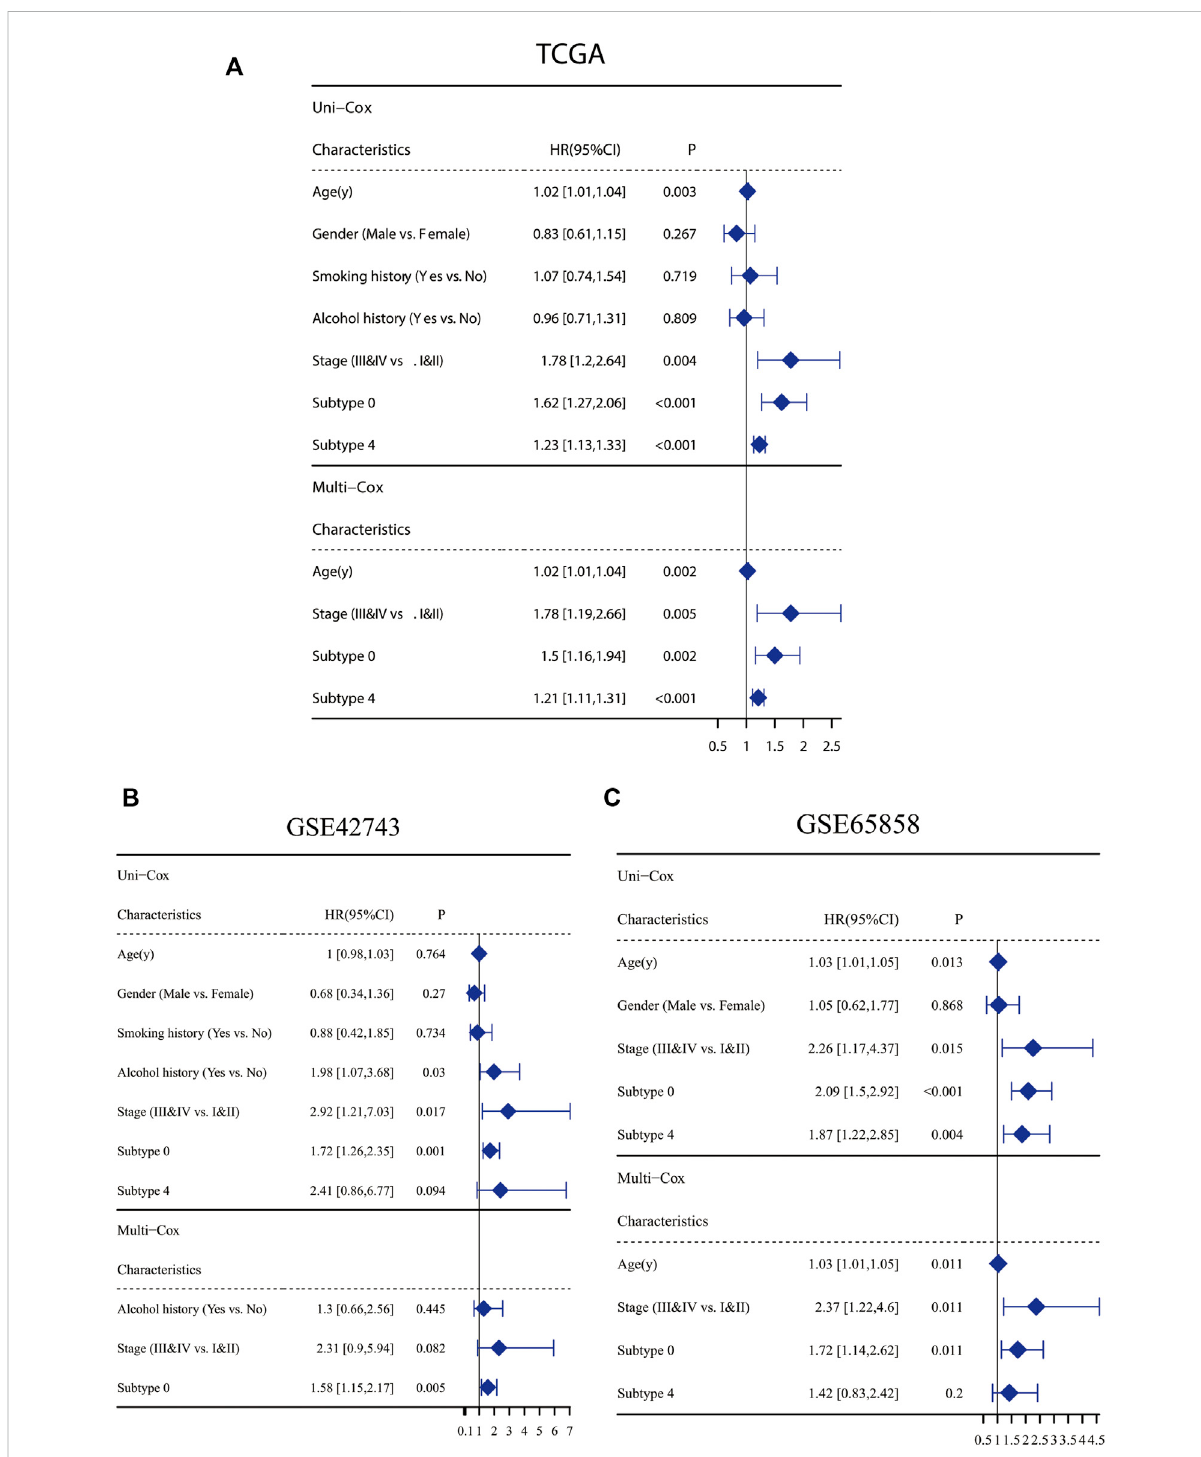
FIGURE 3 Clinicopathological and CAF in fi ltrations correlation of prognosis in HNSC patients. Univariate Cox analysis of clinicopathologic factors and each CAF subtype and multivariate Cox analysis of the signi fi cant factors ( p < 0.05) in TCGA-HNSC cohort (A) , GSE65858 (B) and GSE42743 (C)